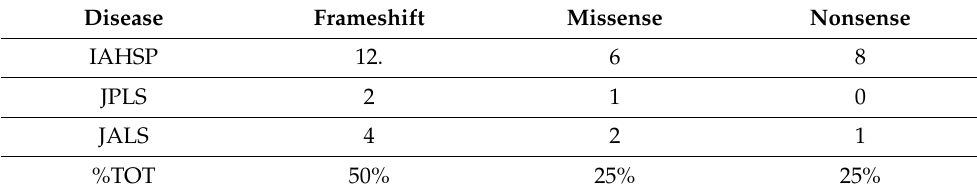
Table 2. Frequency of mutation types of ALS2 related to pathological conditions. Disease